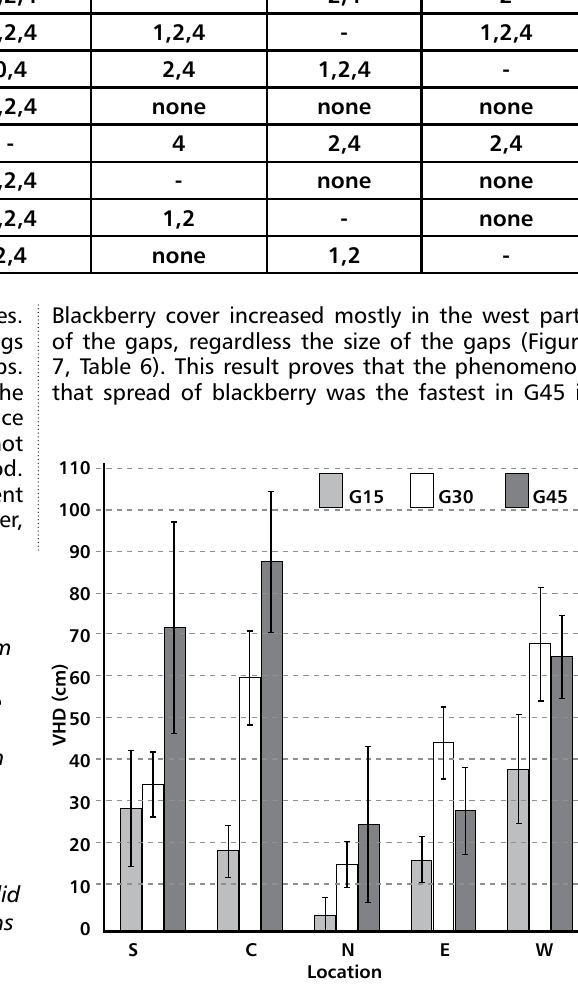
Results of significance tests carried out on height data of sessile oak and hornbeam seedlings (spatial analyses). The cells contain the numbers of those years of the regeneration period in which the corresponding two locations were significantly different at p ≤ 0.05 (i.e. 0 – 2004; 1 – 2005; 2 – 2006; 4 – 2008; none – the two locations were not significantly different in any of the sampling years). The table consists of six half-matrices. Three of them refer to sessile oak (upper half-matrices) and the other three refer to hornbeam (lower half-matrices). To make the results clearer, the backgrounds of the former matrices are shaded. Abbreviations are given at Table 1 and Figure 2.